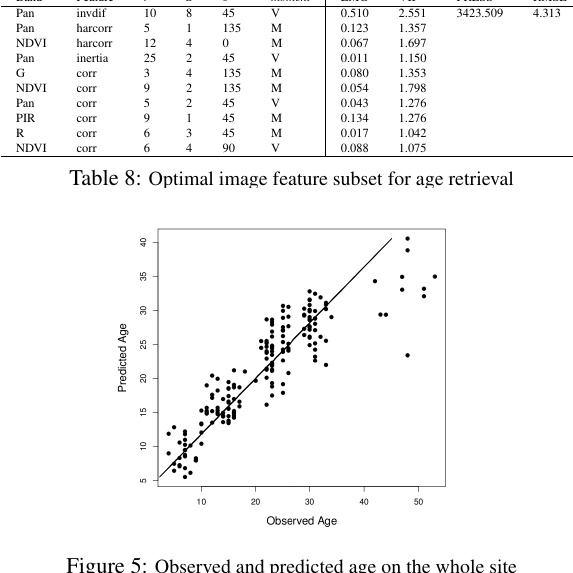
Figure 5: Observed and predicted age on the whole site The predicted variable is relevant for stands younger than 35 years old (Figure